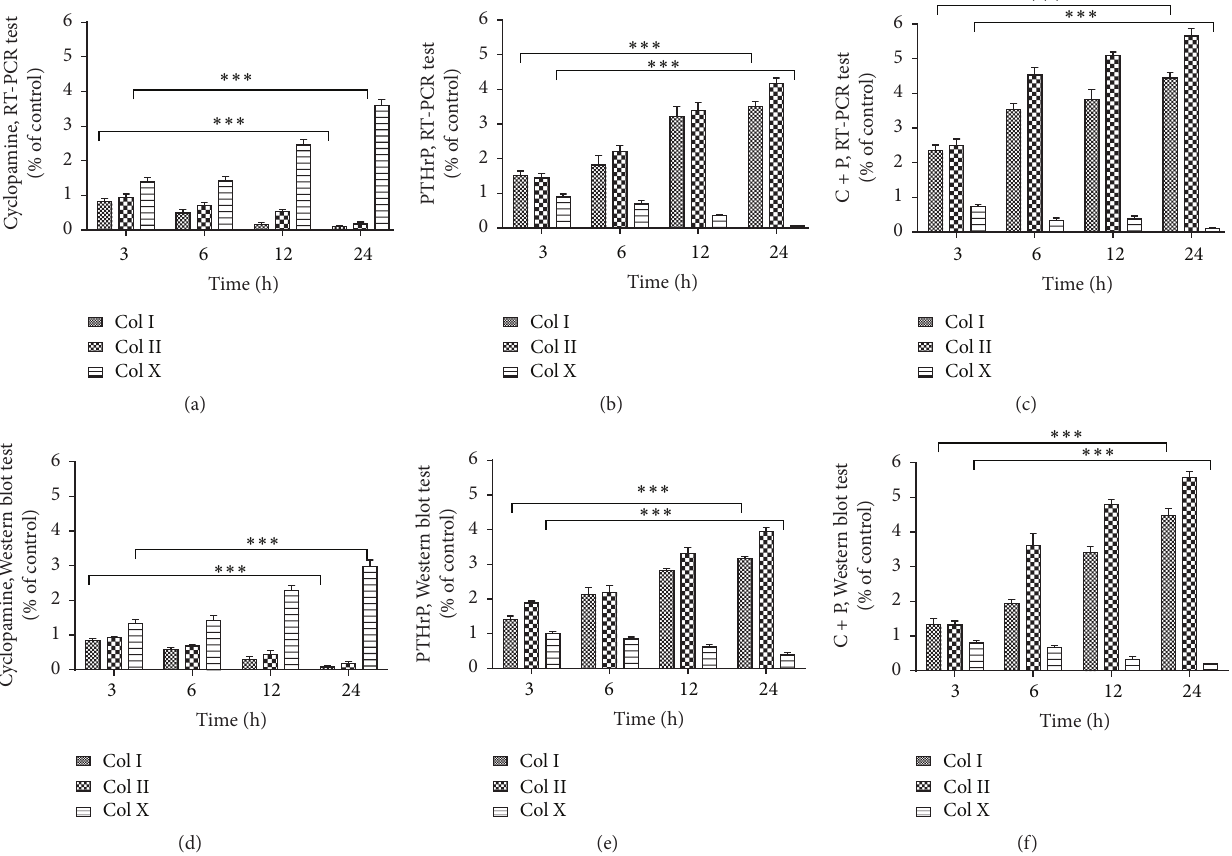
Figure 1: Col I, Col II, and Col X gene expression and protein synthesis under different intervention conditions. Note: (a), (b), and (c) RT- PCR results of Col I, Col II, and Col X gene expression levels by interventions with cyclopamine, PTHrP, and cyclopamine + PTHrP after 3, 6, 12, and 24 h. (d), (e), and (f) Western blot results of protein synthesis under the aforementioned conditions. All data were normalized to the control group ( 𝑛 = 3 , ∗∗∗ 𝑃 < 0.001 , NS: